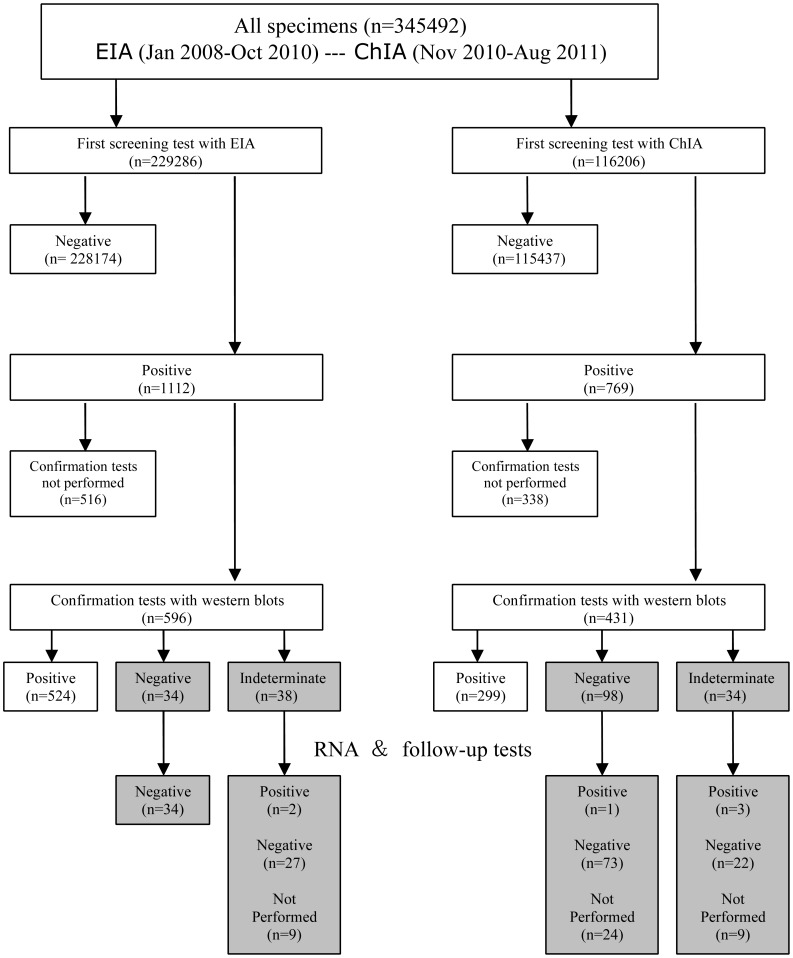
The operational flow chart and comparison of the results obtained by two HIV testing assays.